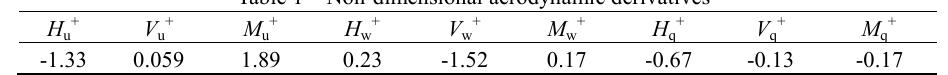
Table 1 Non-dimensional aerodynamic derivatives